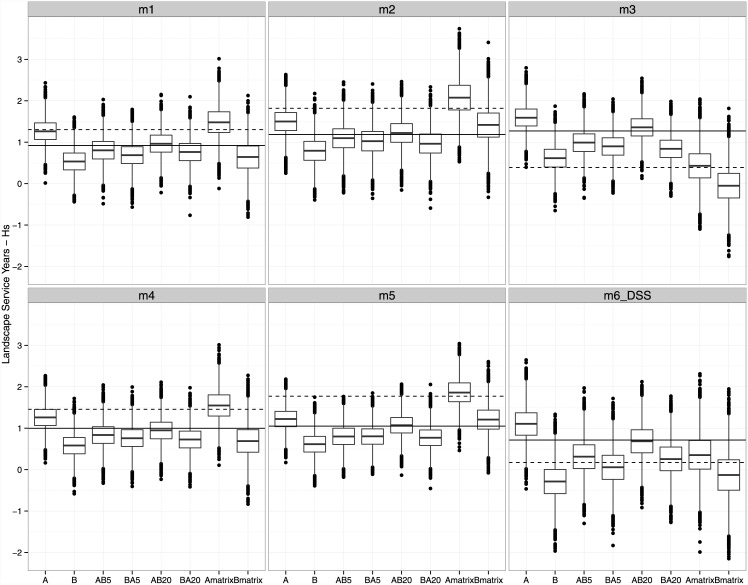
Landscape Service Years for average expected heterozygosity within breeding groups (Hs).Solid horizontal line represents the number of credits available in the bank, prior to a trade, assuming a static matrix and the dashed horizontal line is the number of credits available under a declining matrix. Boxplots of bootstrapped credit values remaining after each trade, with bars represent median values, the box represents the upper and lower 25th quartile, whiskers represent max/min values excluding outliers, and dots represent outliers, or values 1.5 x 25th quartile.